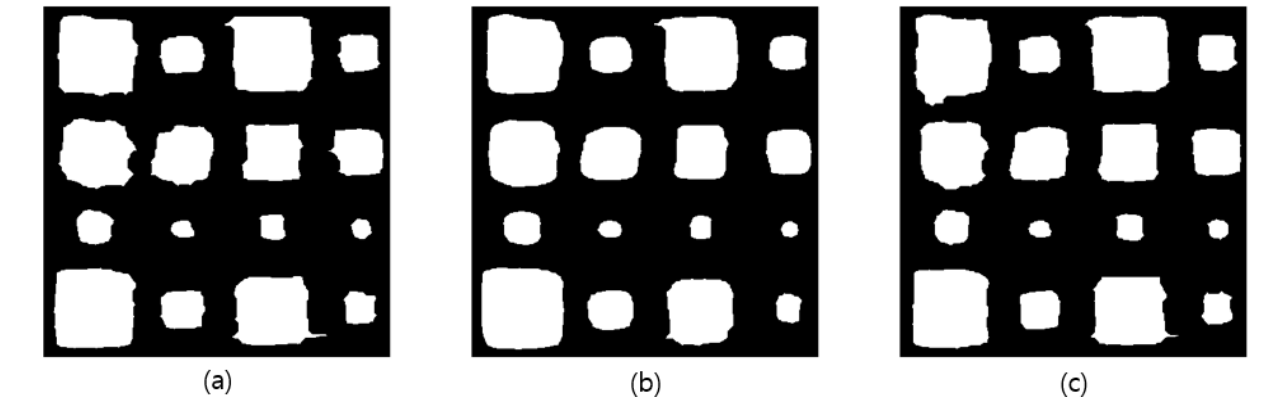
Figure 9. Results of binarized images through Otsu algorithm processing: ( a ) 0.05 Hz, ( b ) 0.1 Hz, ( c ) 0.2 Hz.